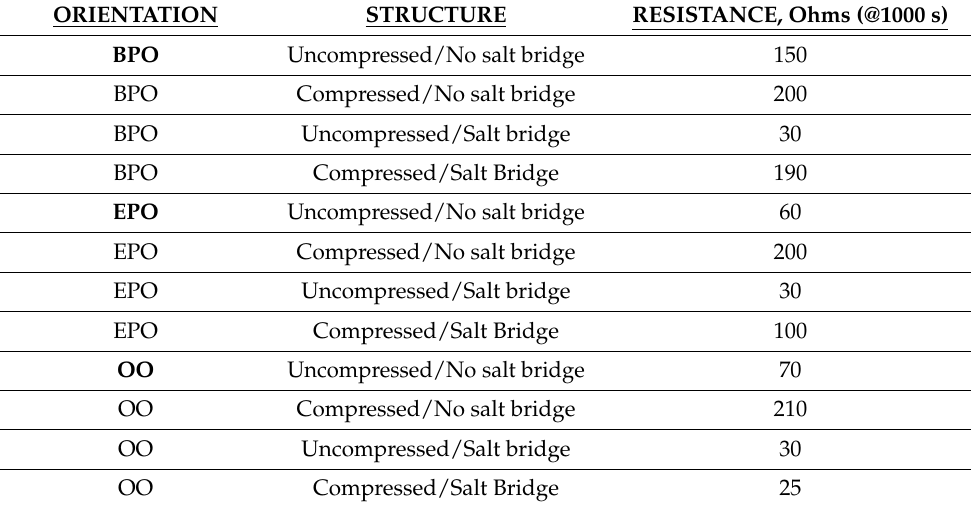
Table 2. ESR as a function of orientation, compression, and salt bridge.